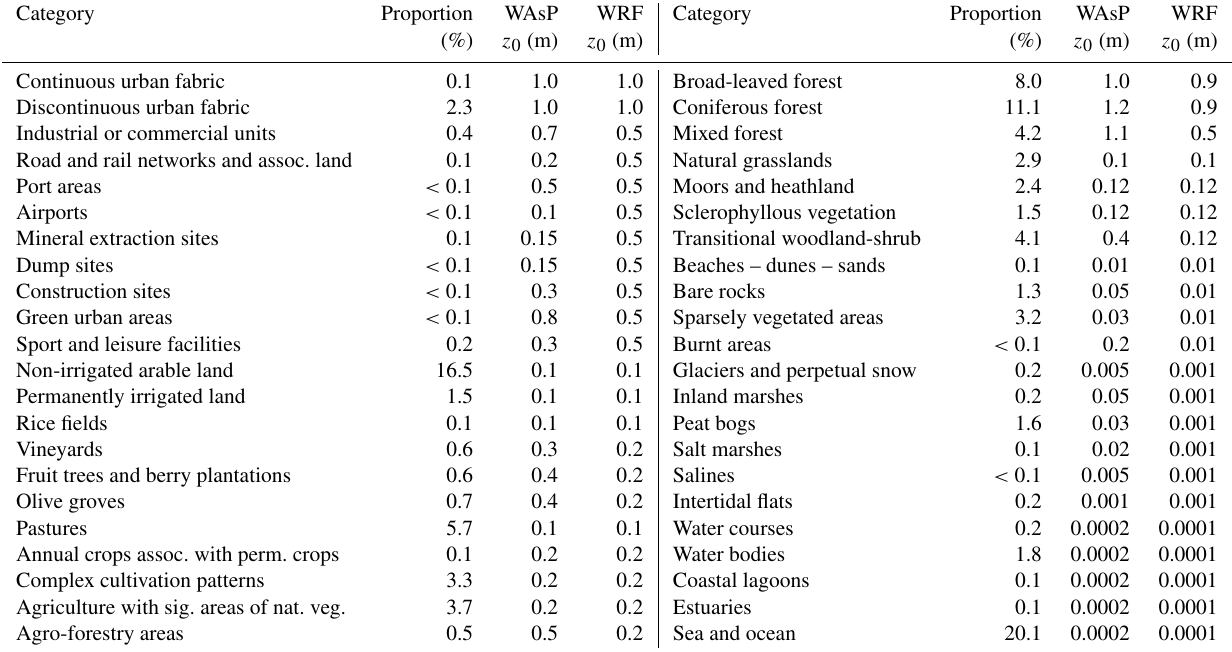
Table 2. Surface roughness length [m] for each land use category in WAsP and WRF and the proportion it represents in the total dataset. Category Proportion WAsP WRF Category Proportion WAsP